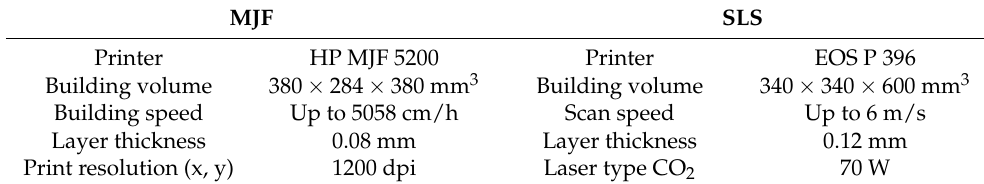
Table 1. Parameters of manufacturing test samples.